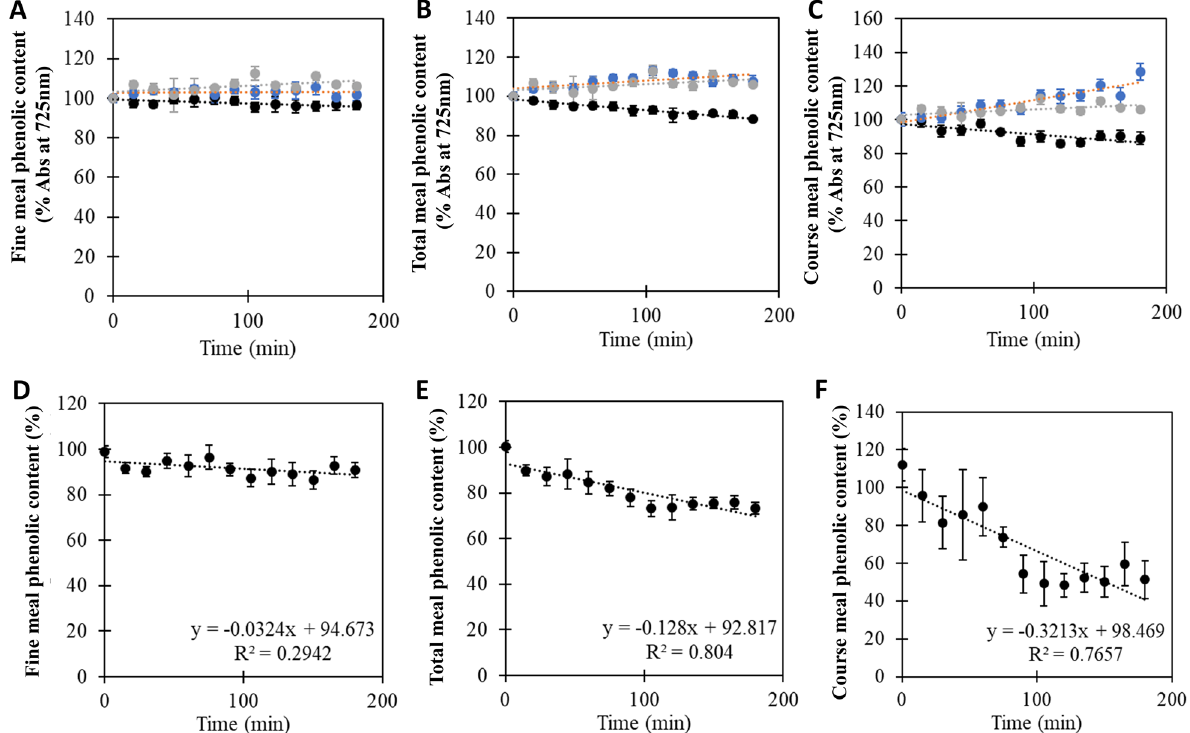
Fig. 4 Biocatalytic reduction of phenols in faba bean meal using BLC23O. Phenolic content in faba bean total, fine and coarse meal fractions was evaluated in the presence (black) and absence (blue) of BLC23O over time. An enzyme-only control sample was also assessed (grey). Reactions between each meal type and BLC23O were initiated with the addition of 0.06 mg/mL of enzyme. Samples were taken in 15-min intervals and reacted with the Folin–Ciocalteu reagent. Time zero was set to 100% phenol and changes in absorbance at 725 nm plotted on a percentage change basis with A fine, B total and C coarse meal fractions. The observed changes in phenol content of BLC23O-treated D fine, E total and F coarse meal fractions were quantified relative to untreated fractions. The data represent the mean and standard deviation ( n data and the corresponding equations and coefficients of determination are